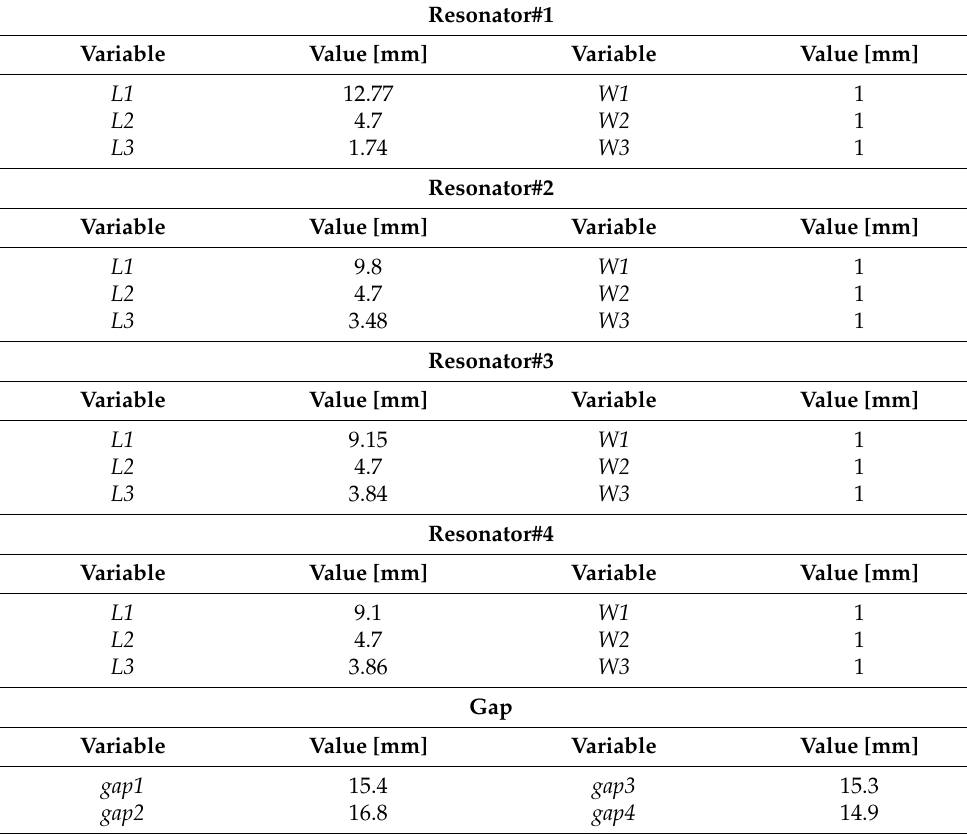
Table 7. The values of the physical dimensions of the eighth-order filter, considering